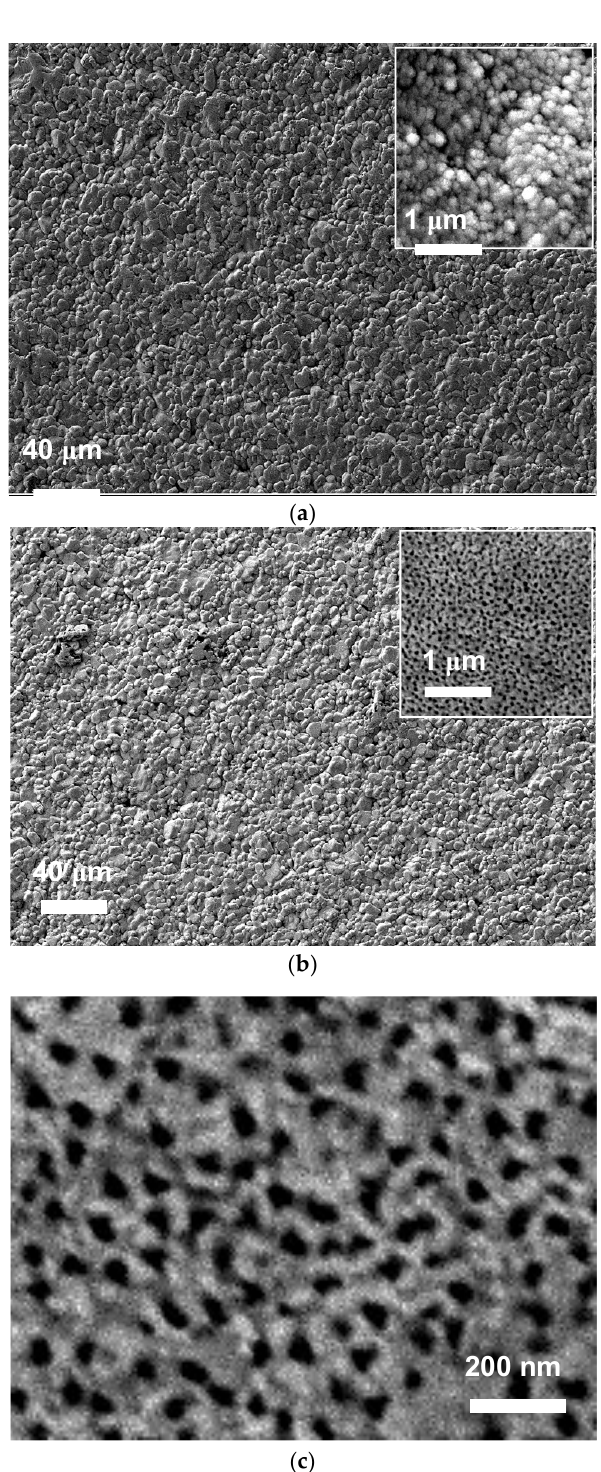
Figure 3. Morphology of Ti screen-printed electrodes ( a ) before and ( b ) after the anodic oxidation treatment. ( c ) High magnification image of TiO 2 grown on the Ti electrode showing the highly porous array structure.